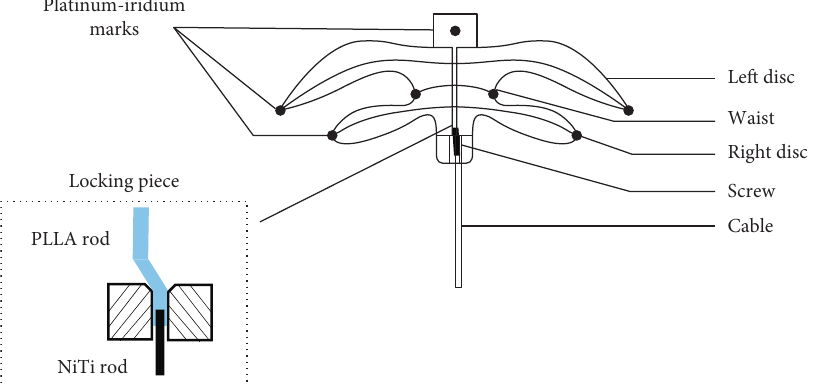
Figure 2: Schematic representation of PLLA device design. The seven platinum-iridium marks are shown on the device. A PLLA rod is connected to a NiTi rod to form the main structure of the locking